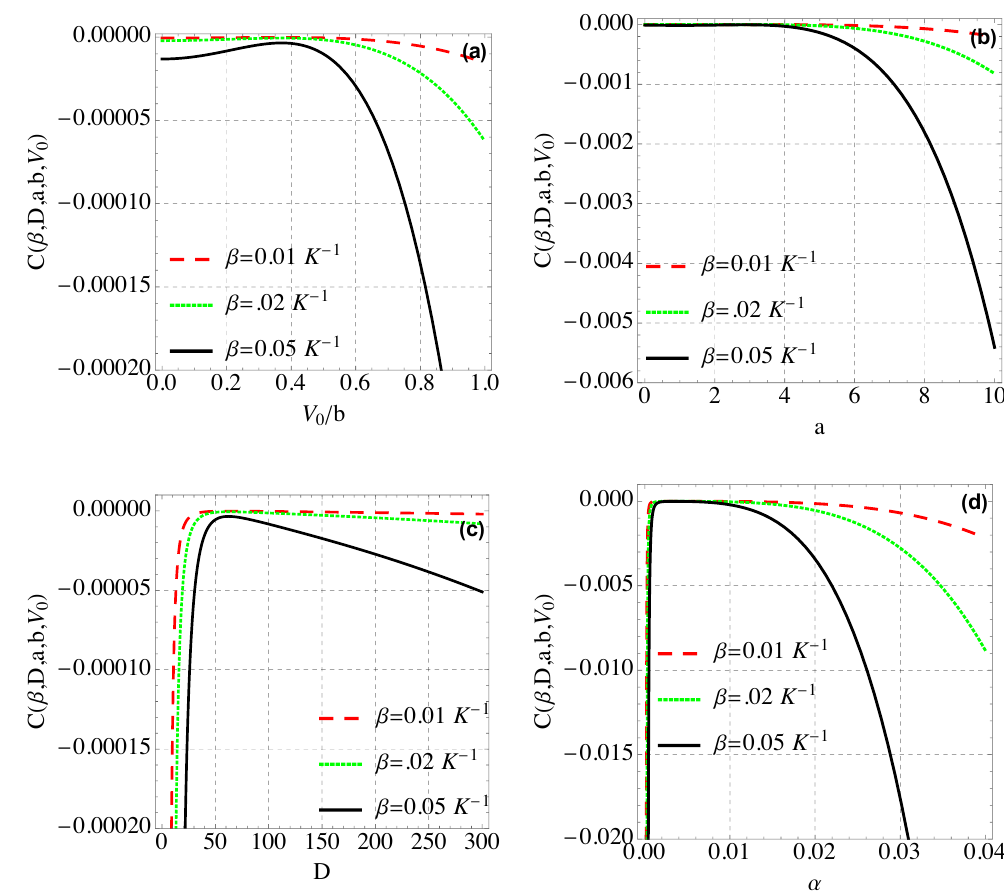
Figure 5. ( a ) Plots of specific heat capacity C ( β , D , a , b , V 0 ) as a function of V 0 / b , ( b ) parameter a , ( c ) dimension D , and ( d ) screening parameter α for β = 0.01K − 1 (red curve), 0.02K − 1 (green curve), and 0.05K − 1 (black